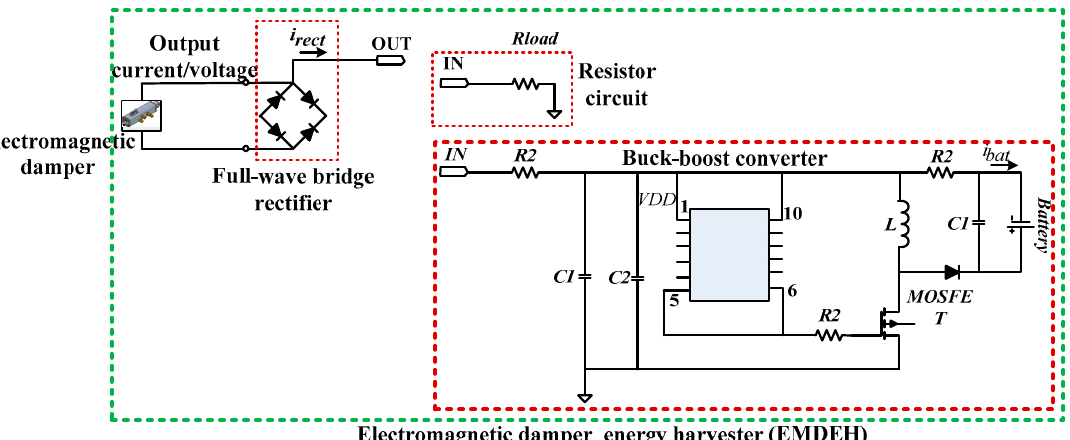
Figure 23. Symmetry of EMDEH in energy harvesting for vibration control [124].